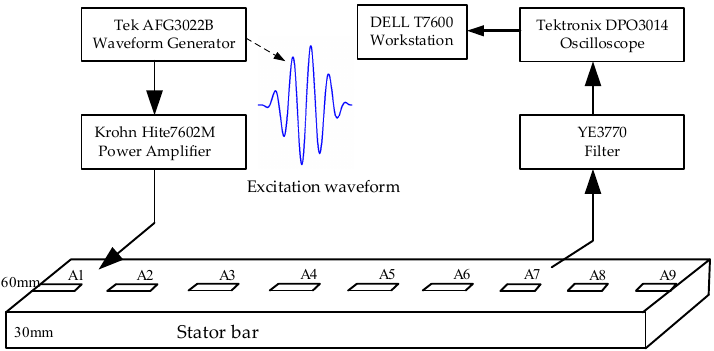
Figure 4. Structural diagram of the experimental system used for stator insulation damage detection.